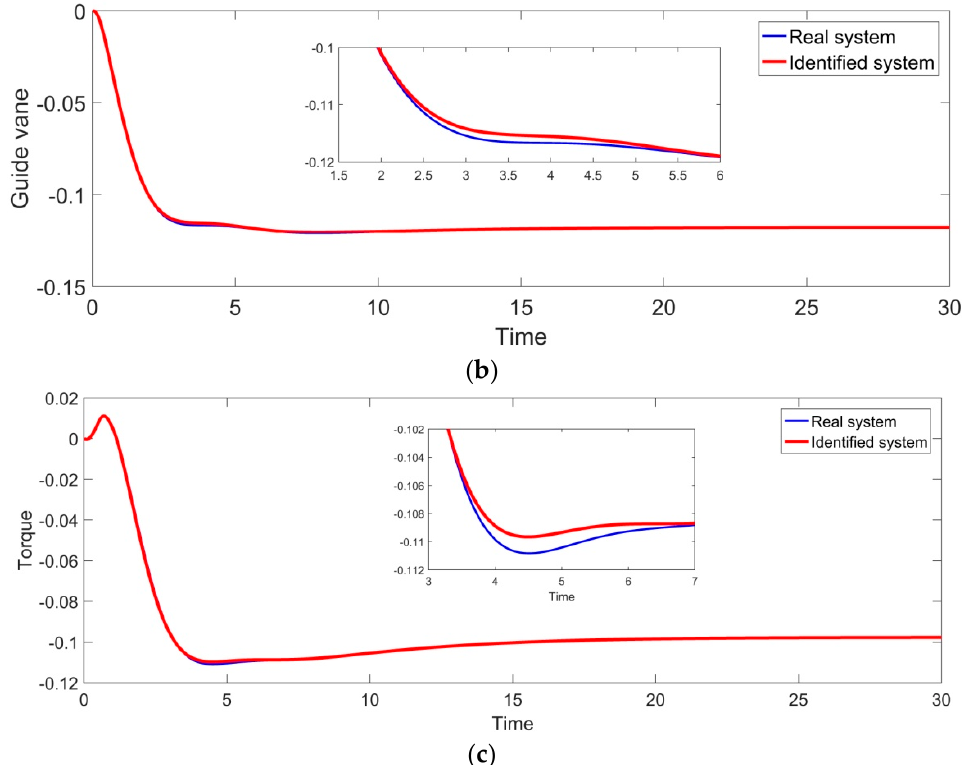
Figure 11. Comparison of system outputs using MSWOA under load conditions; ( a ) Comparison curves of turbine speed; ( b ) Comparison curves of guide vane; ( c ) Comparison curves of turbine torque.